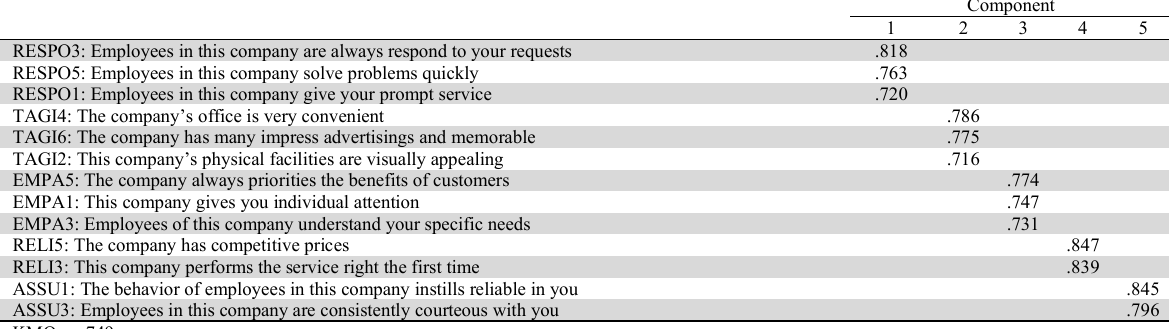
Rotated Component